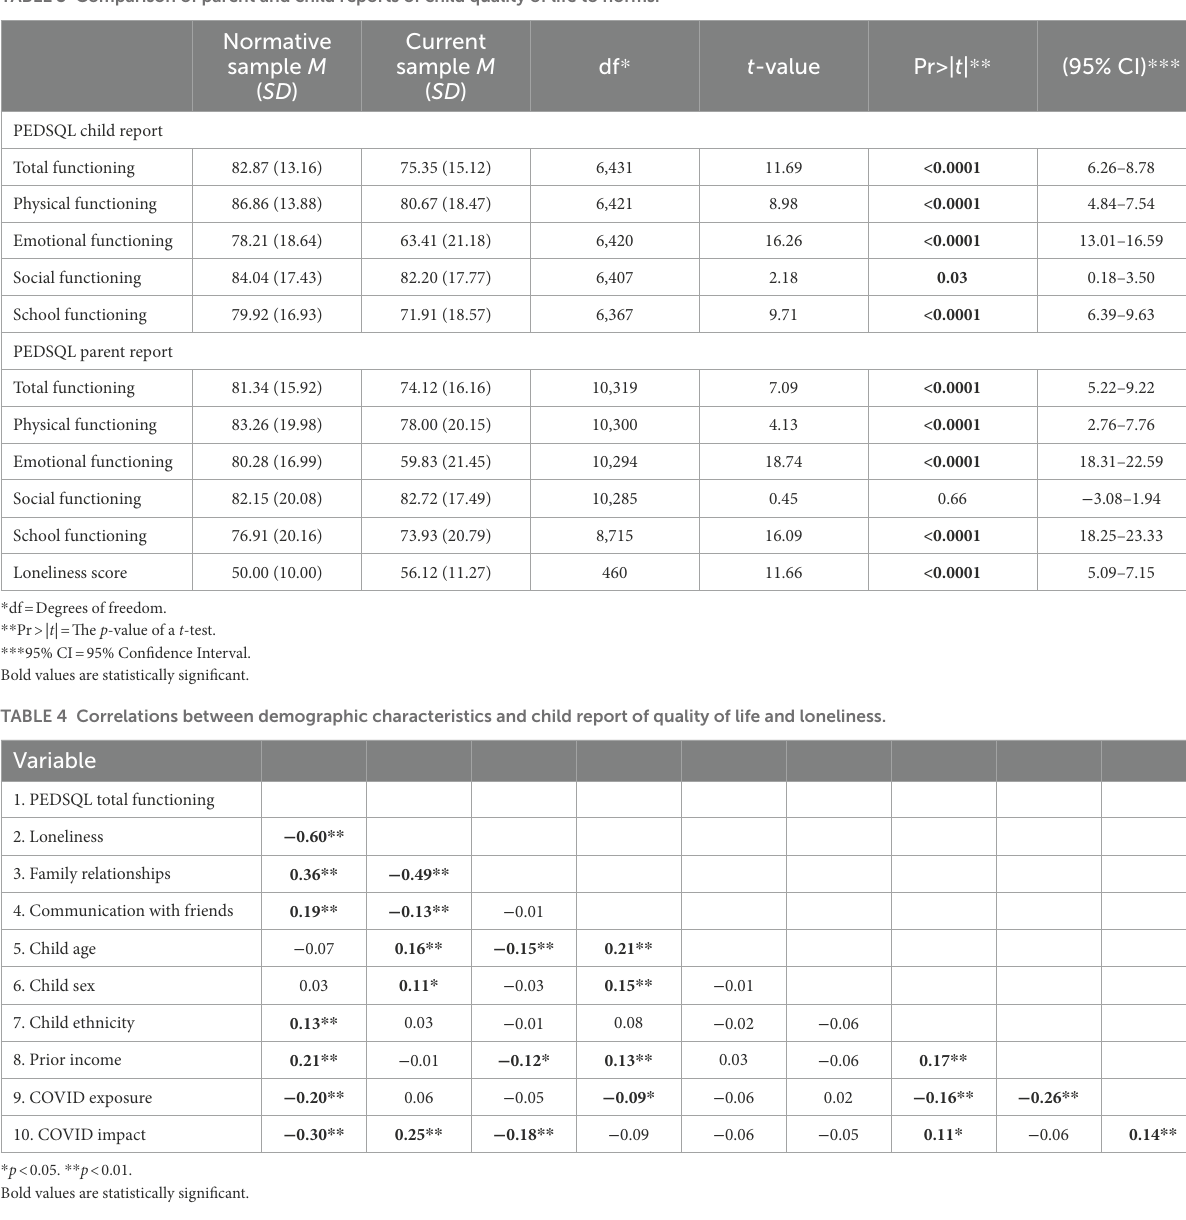
TABLE 3 Comparison of parent and child reports of child quality of life to norms.